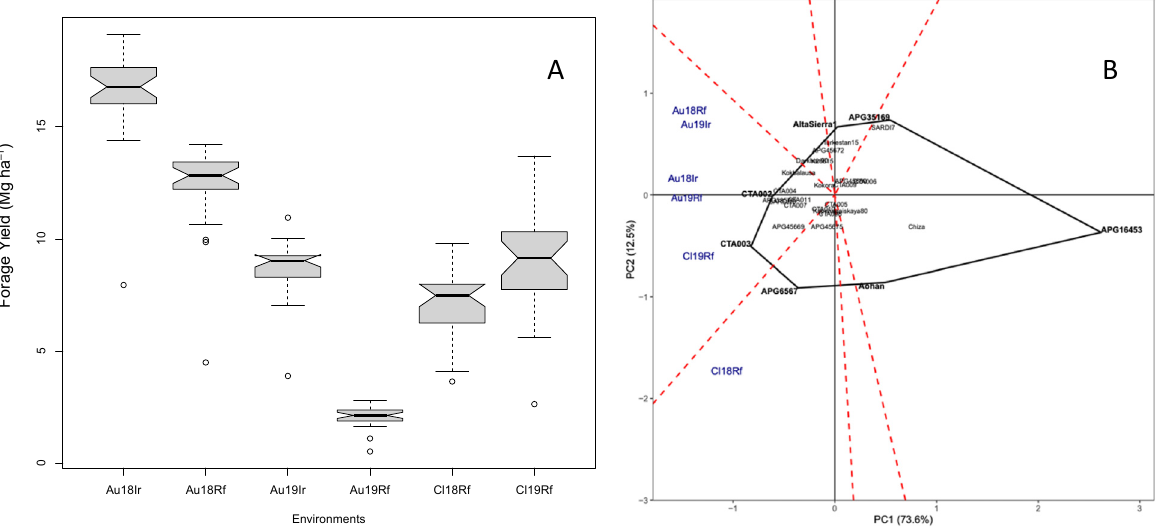
Figure 4. Frequency distribution (box plot; A ) and GGE biplot ( B ) of annual forage yield evaluated in 30 alfalfa accessions in drought-prone environments of Chile and Australia during the first and second growing season after the establishment year. GGE biplot corresponds to the first two principal components (PC1 and PC2) for the principal component analysis of annual forage yield evaluated in six environments: rainfed experiment in Australia in 2017–2018 (Au18Rf) and 2018–2019